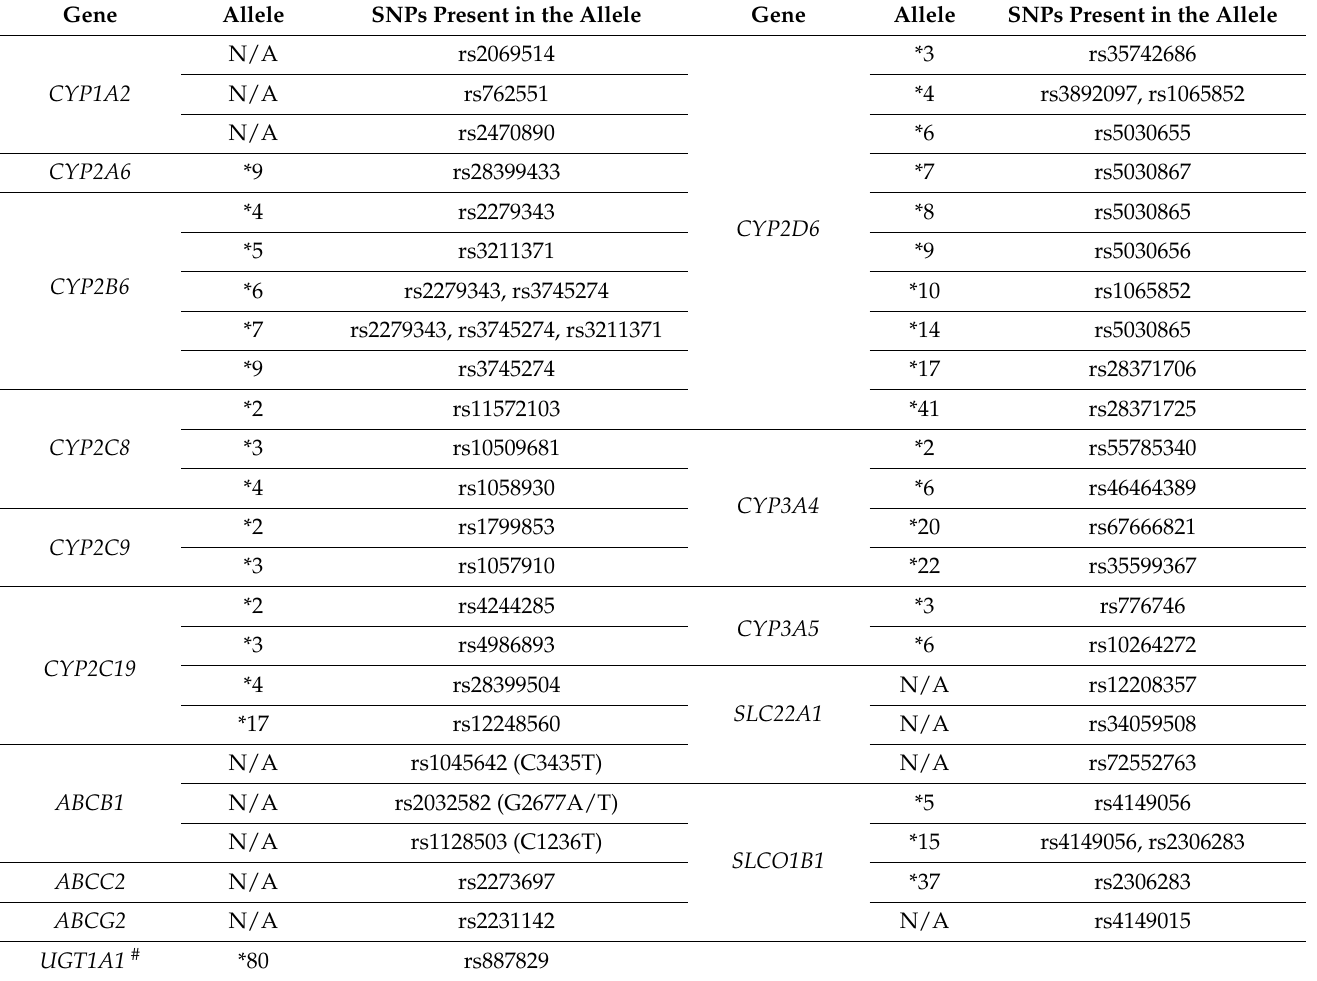
Table 1. Genotyped SNPs and alleles in which those SNPs are